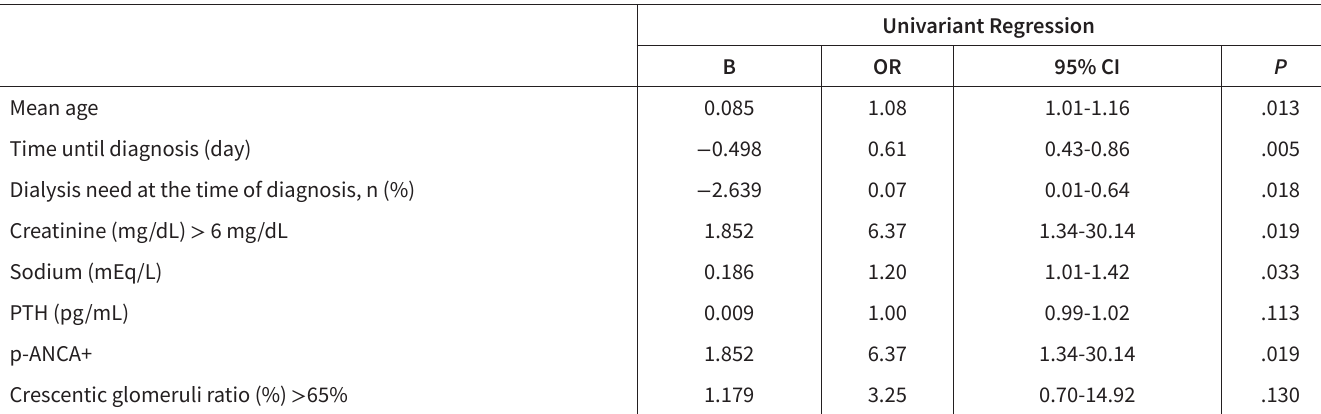
Univariant Regression